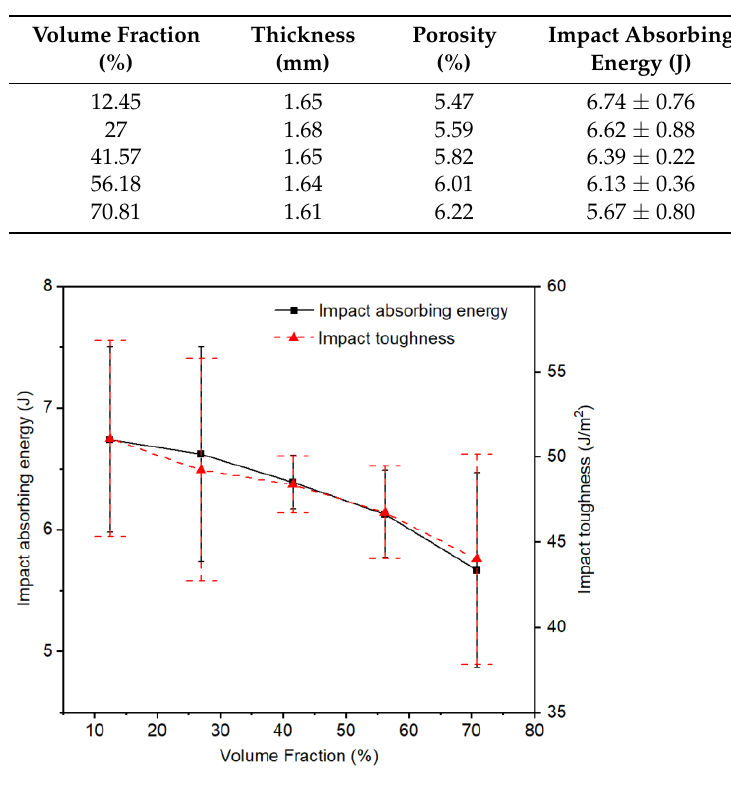
Table 2. Charpy impact properties of PWMCPPs with different wire mesh volume fractions.